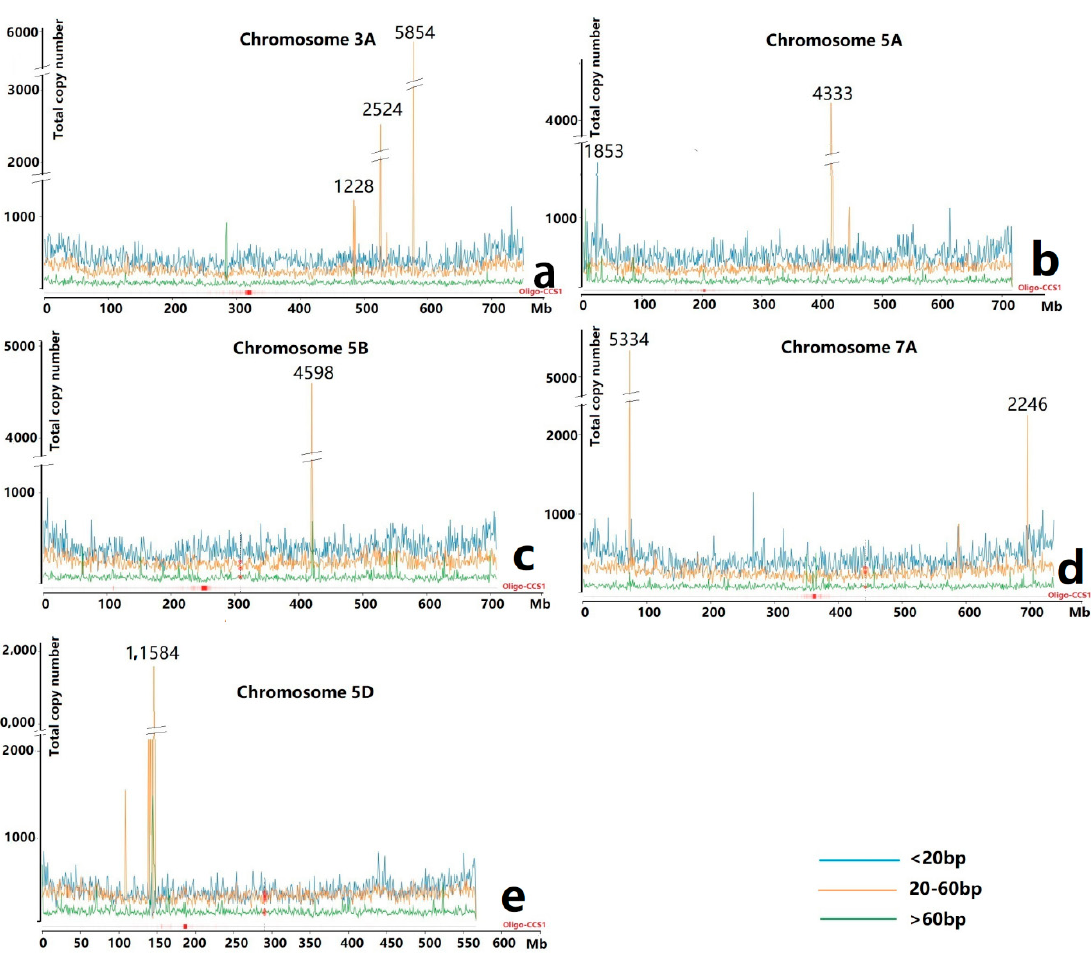
Figure 1. The copy number and distribution of tandem repeats in wheat chromosomes 3A ( a ), 5A ( b ), 5B ( c ), 7A ( d ), and 5D ( e ). The copy number was predicted for wheat Chinese Spring genomic sequences v 1.0 at a web server at http://mcgb.uestc.edu.cn/BD2SC with default parameters. Table 1. The predicted copy numbers of Ta-3A1 on sequenced Triticum urartu , Aegilops tauschii , T. dicoccoides , and T. aestivum